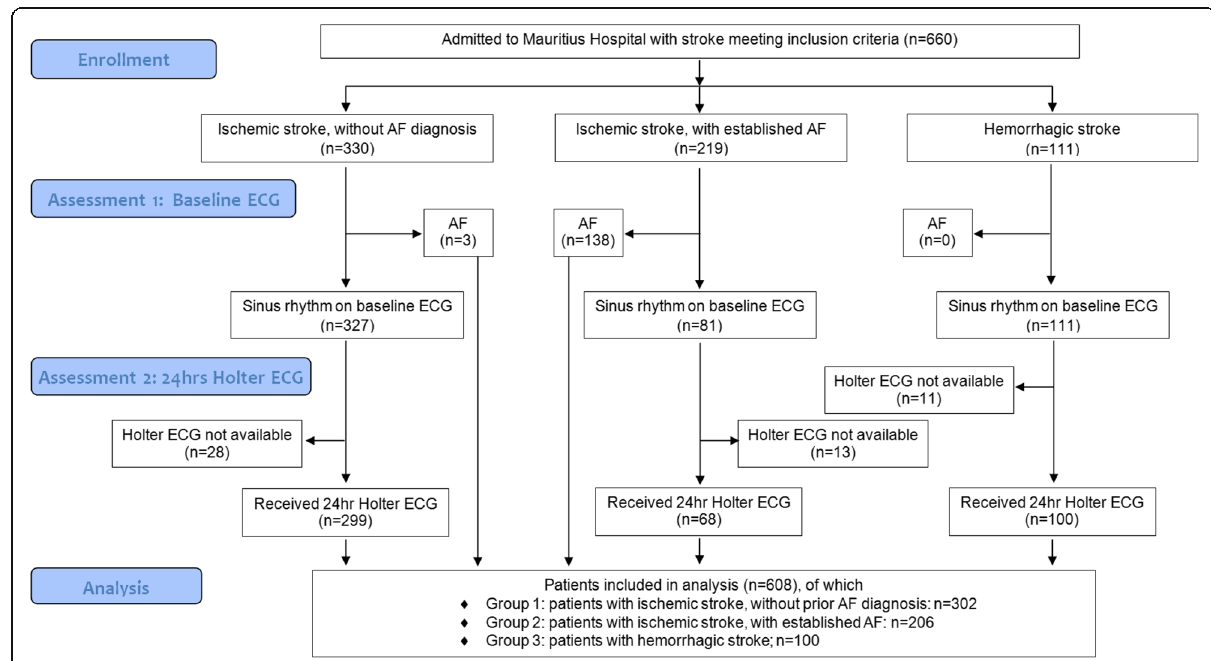
Fig. 1 Selection of patients evaluated in the study. Note that ECG assessment was sequential, consisting of a baseline ECG and if negative a Holter